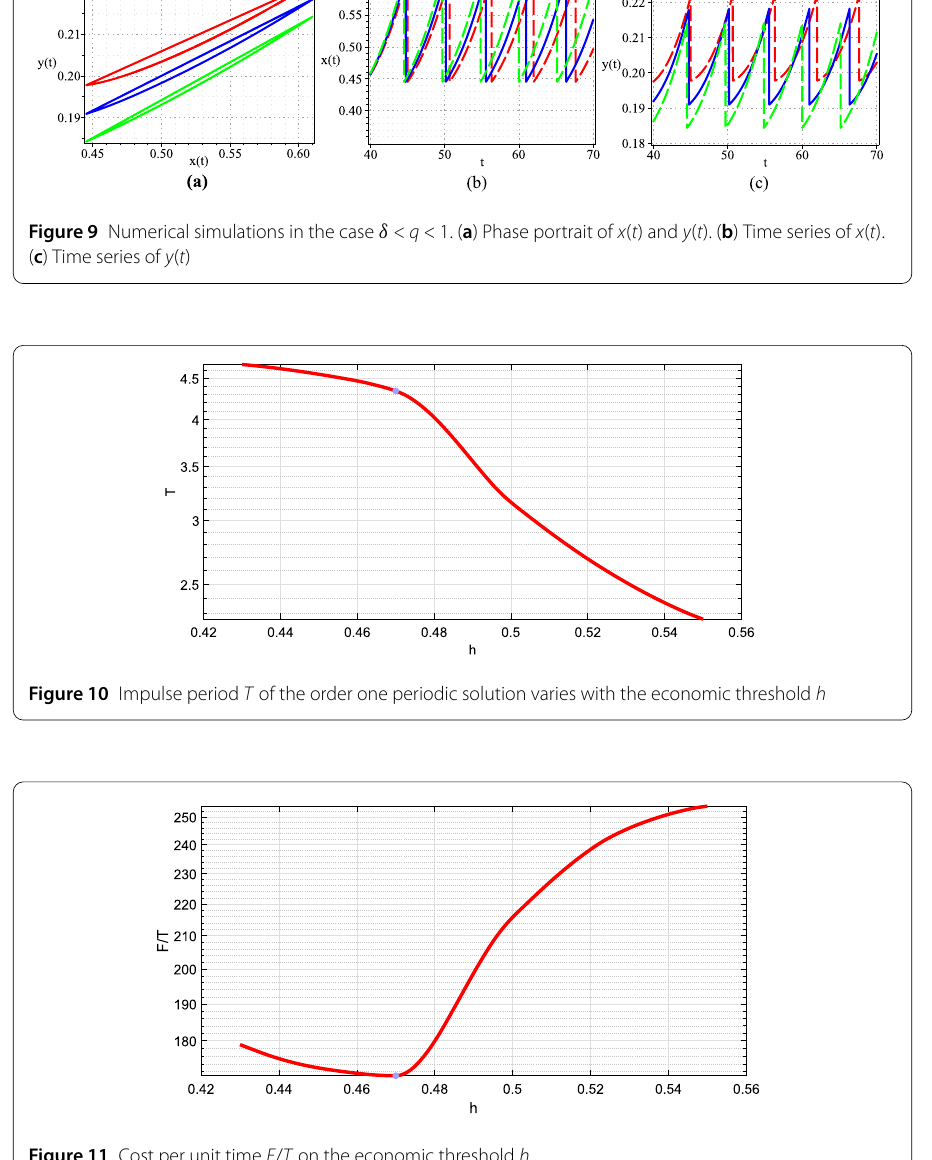
Figure 11 Cost per unit time F / T on the economic threshold